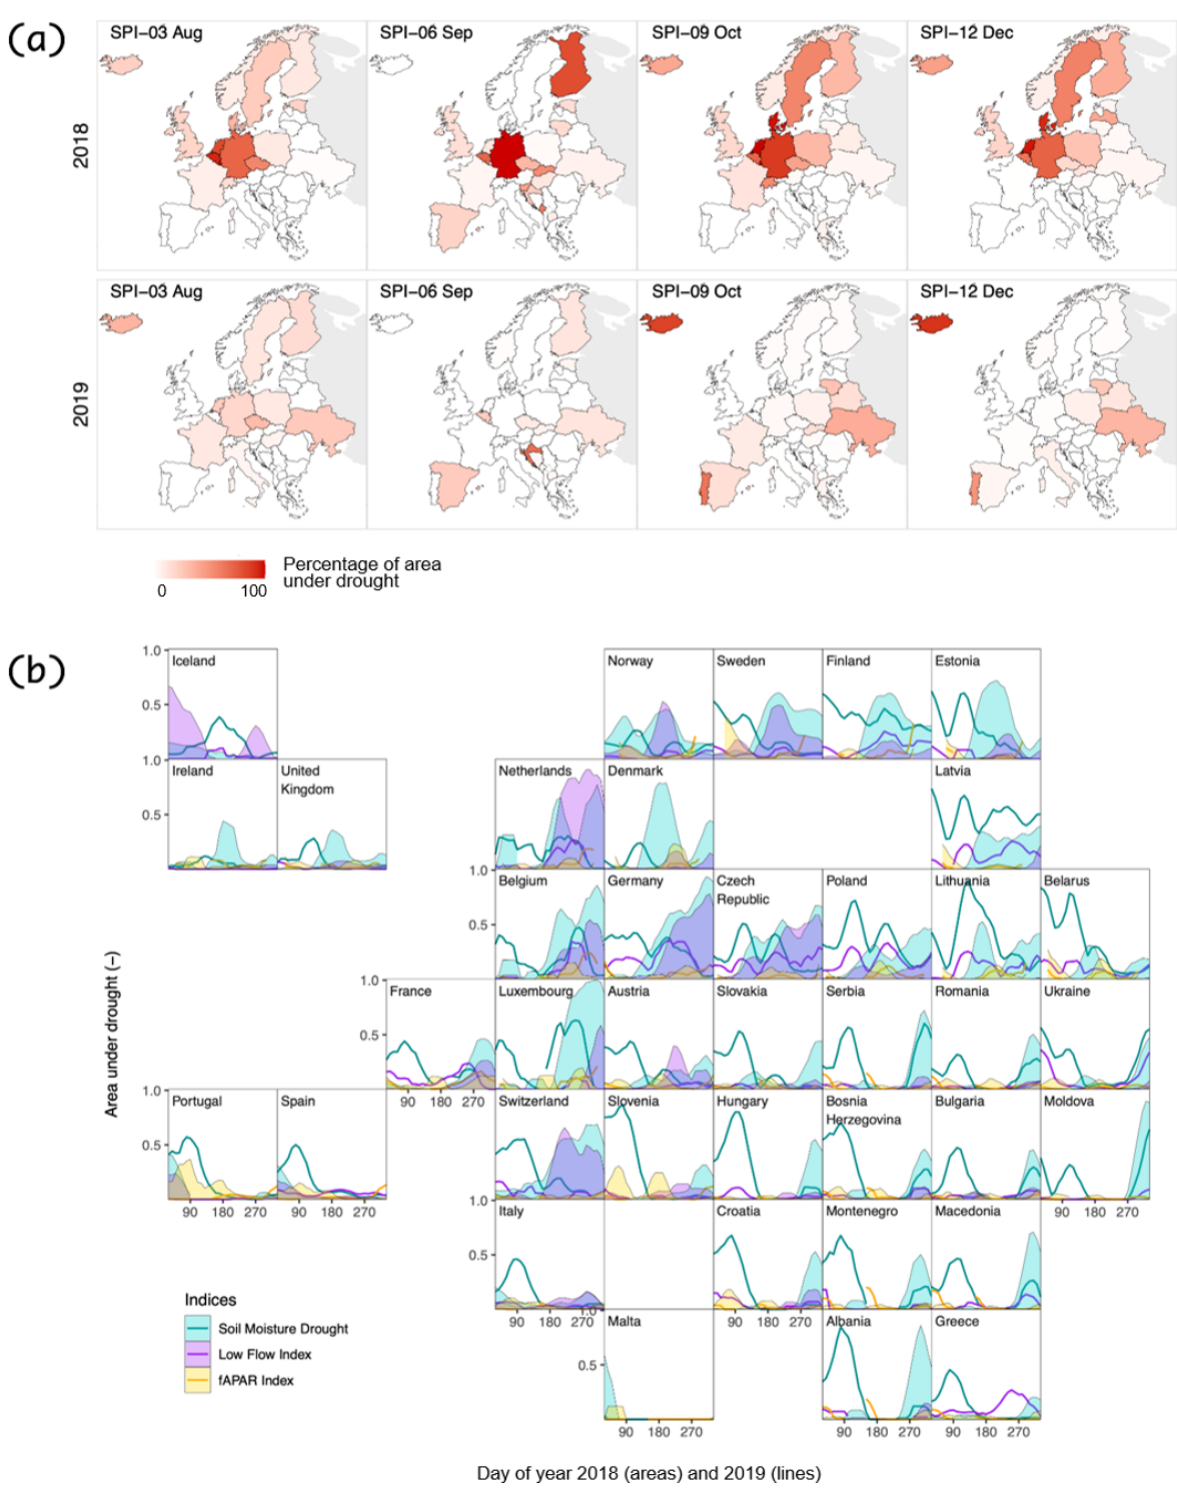
Figure 1. (a) Drought hazard conditions for 2018 and 2019 across the European continent according to the European Drought Observatory indicator fact sheets (https://edo.jrc.ec.europa.eu/edov2/php/index.php?id=1101, last access: 1 April 2022). Data are presented as the pro- portion of the country’s total area under severe (or extreme) drought hazard conditions. Standardised Precipitation Index (SPI) is shown for accumulation periods of 3, 6, 9, and 12 months for August (AUG), September (SEP), October (OCT), and December (DEC). (b) SM is Soil Moisture Anomaly/Index, LFI is Low Flow Index, and FAPAR is Fraction of Photosynthetically Active Radiation, all presented for the day of the year in the corresponding colouring: 2018 as area and 2019 as